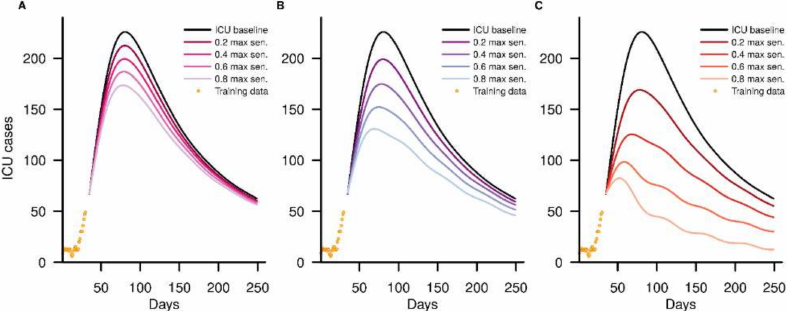
Figure 5. Baseline ICU cases and dampening of ICU case trajectories with RRT intervention at early implementation at various maximal test sensitivity (0.2, 0.4, 0.6, 0.8), with ( A ) fortnightly testing, ( B ) weekly testing and ( C ) tridaily